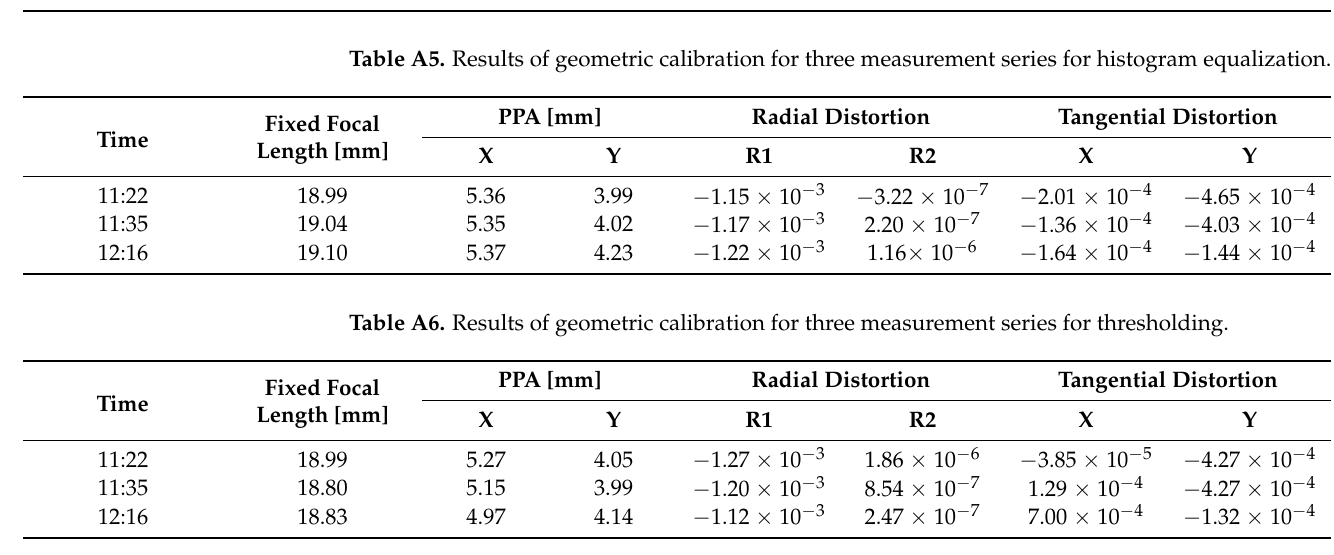
Table A7. Results of geometric calibration for three measurement series for brightness and contrast